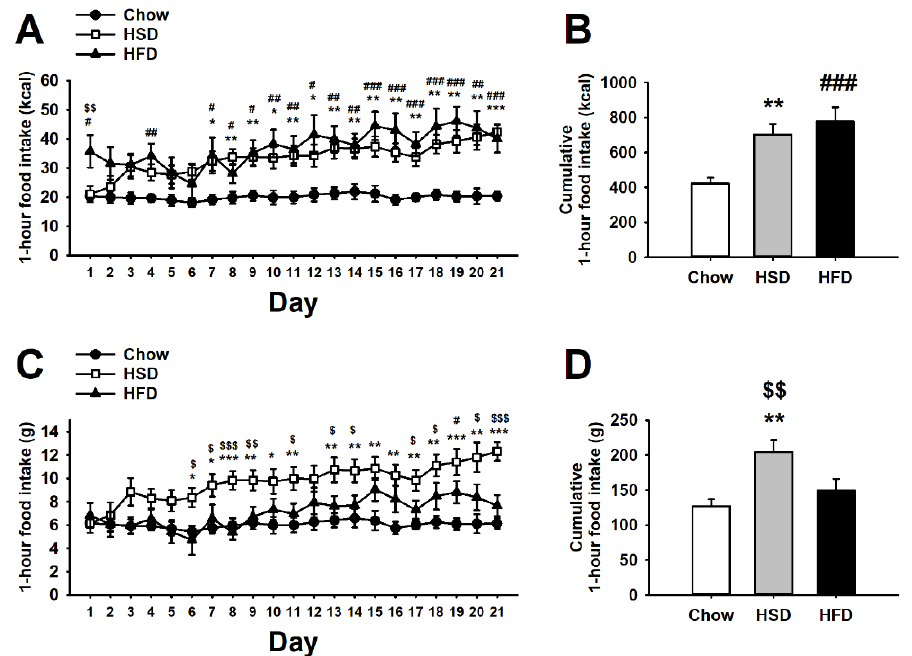
Figure 2. Effects of daily 1-h operant self-administration of Chow, HSD, or HFD on ( A ) food intake (kcal), ( B ) cumulative food intake (kcal), ( C ) food intake (g), and ( D ) cumulative food intake (g) in female Sprague Dawley rats ( n = 10/group). Rats were given the chance to self-administer one of the three diets in a fixed ratio 1 schedule during a 21-day period. Chow was otherwise freely available in the home cages. Panels represent M ± SEM. Symbols denote the following: * HSD differs from Chow,